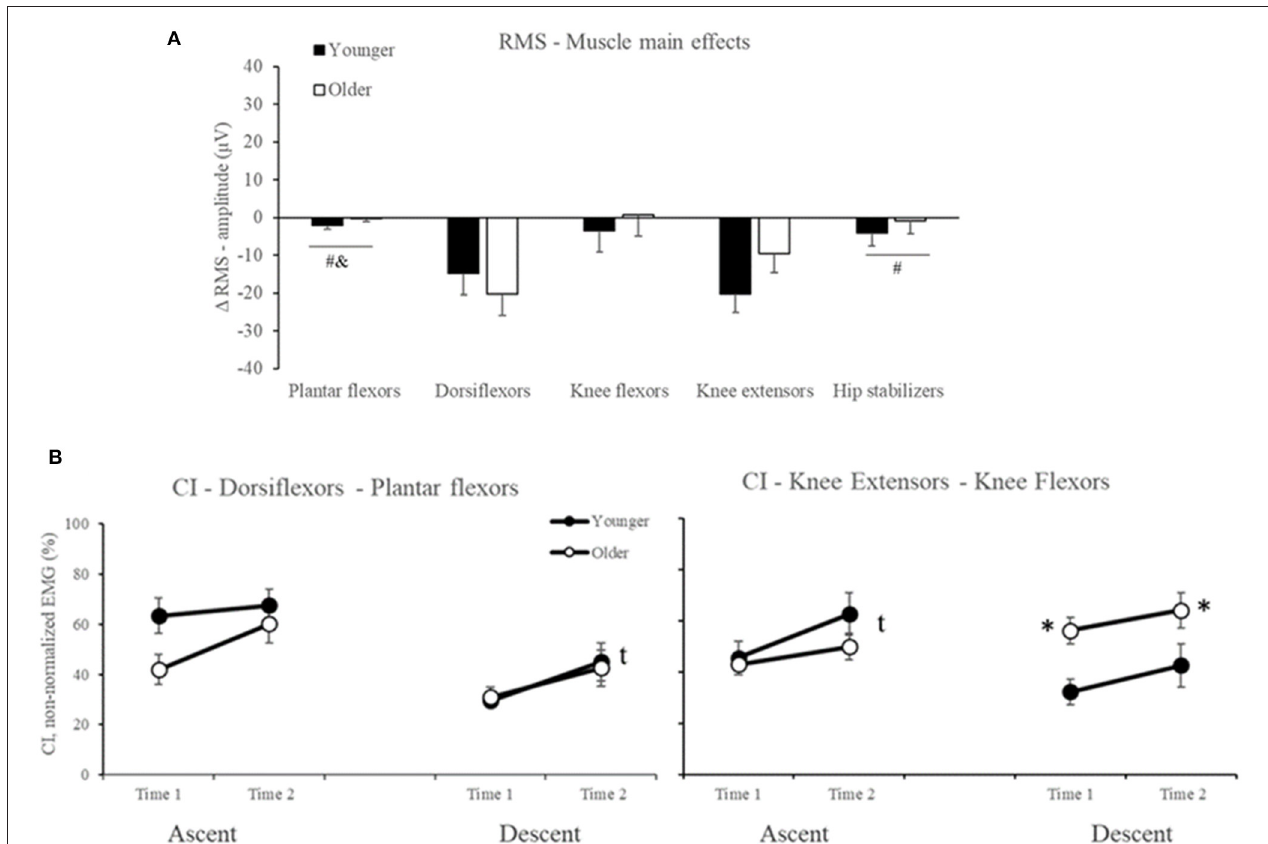
FIGURE 5 | Mean and Standard Error for (A) Muscle main effects for the delta score in RMS-amplitude (B) co-contraction index (CI) between dorsiflexors and plantar flexors, and between knee extensors and knee flexors in younger (filled symbols) and older (open symbols) adults. *Age differences, t Time main effect. # muscles that are different from dorsiflexors; & muscles that are different from knee